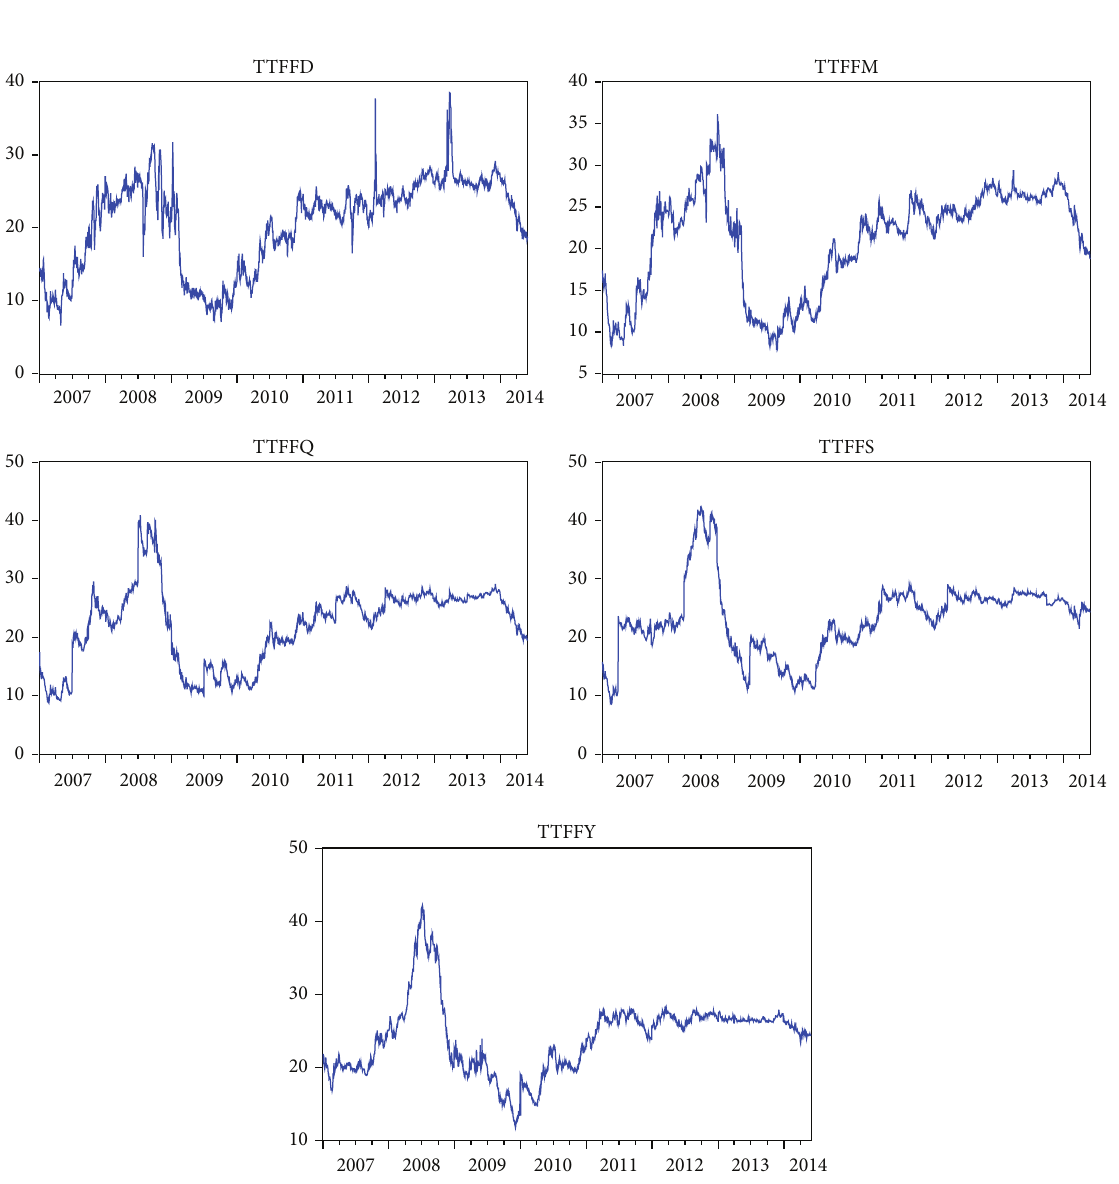
Figure 1: The time series plots of daily natural gas spot and futures prices at the Title Transfer Facility (TTF) Hub. Table 1: Descriptive statistics of spot and generic futures returns for natural gas